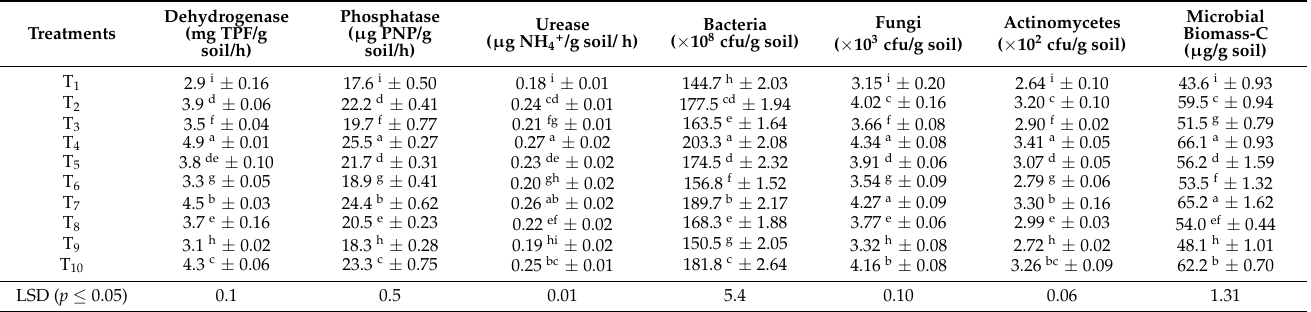
Table 6. Effects of panchagavya, jeevamrut, and organic manures on the microbiological properties of the